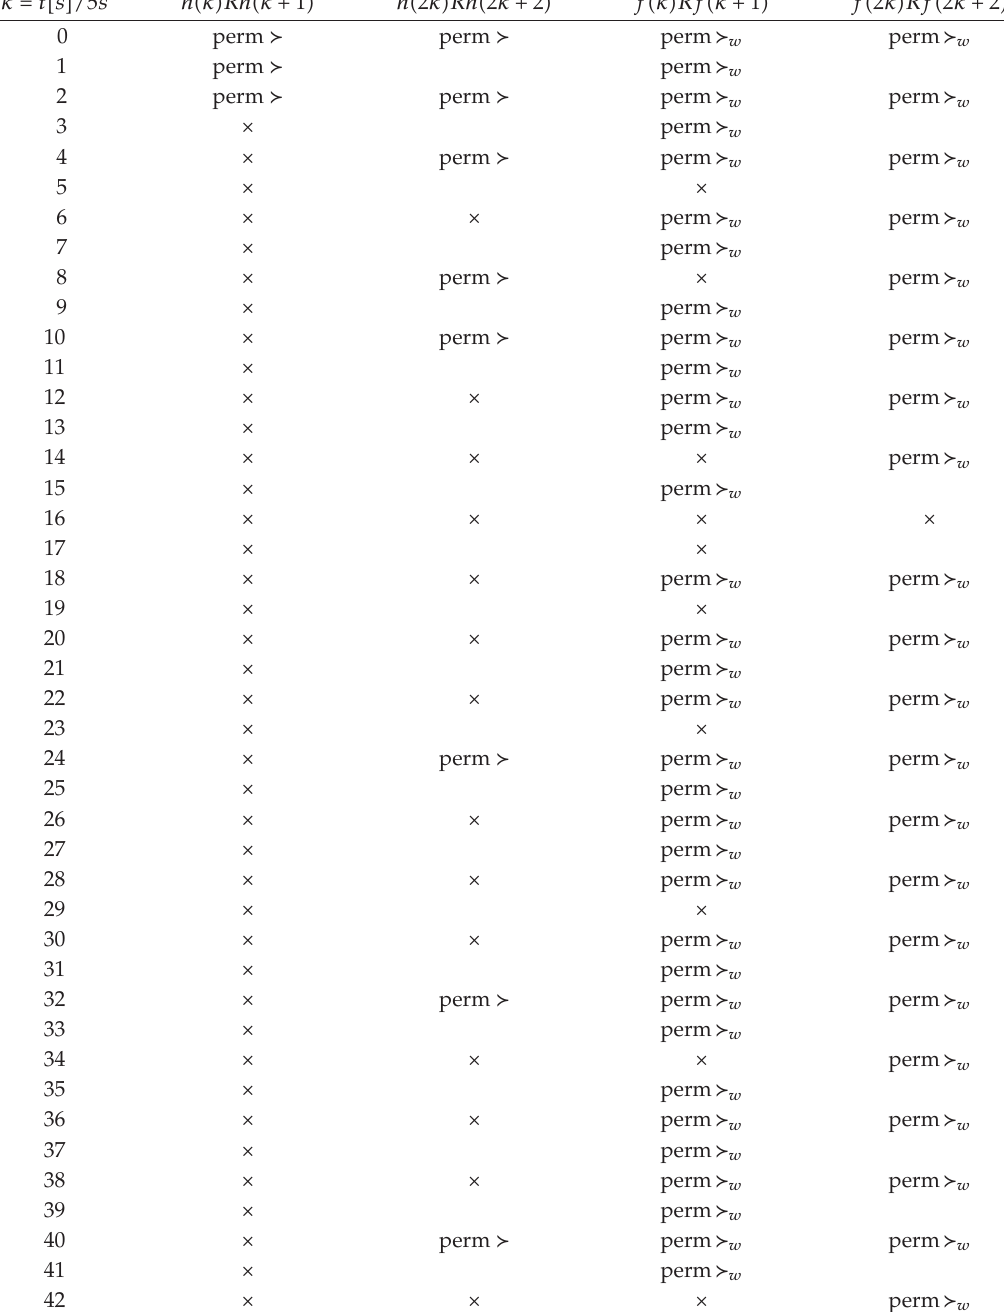
Table 3: The evaluation of the di ff erent concepts of perm-majorization. In the first column the time steps are given. One sees the relation R of the perm-majorization in the second column and the weak perm- submajorization in the third column. Incomparableness are denoted by ×